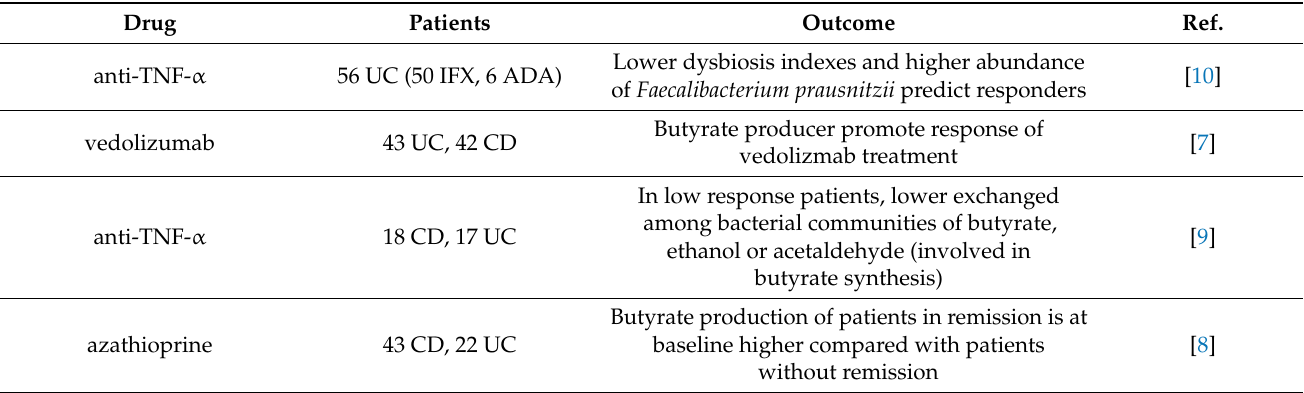
Table 1. Effects of butyrate and butyrate-producing bacteria on therapeutic efficacy of drugs. Drug Patients Outcome